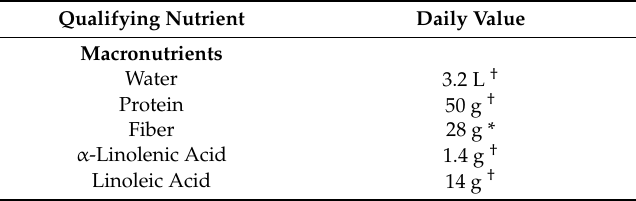
Table 2. Summary of daily values (DV) for qualifying nutrients and mean reference values (MRV) for disqualifying nutrients for Canadian adults used to calculate the qualifying index, disqualifying index, and nutrient balance score for reformulated and traditional